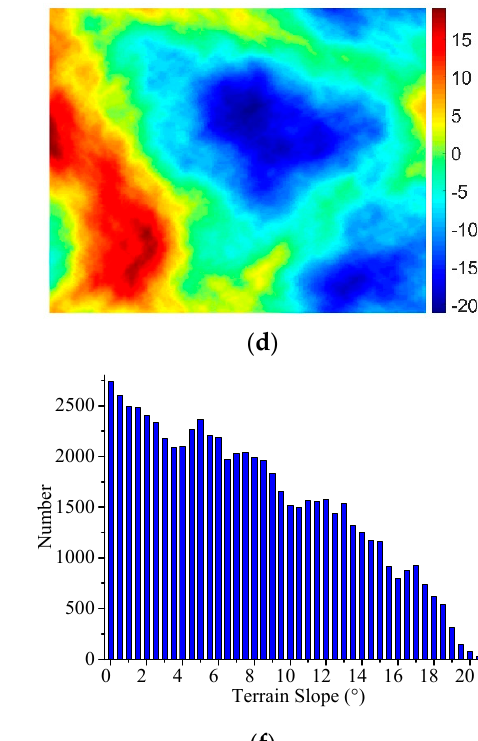
Figure 11. Simulated DEMs ((a) and (b)), terrain slope maps ((c) and (d)) and interval histograms with 0.5 degree steps ((e) and (f)). ( a ), ( c ) and ( e ) Correspond to one simulated data set; and ( b ), ( d ) and ( f ) correspond to the other data set.